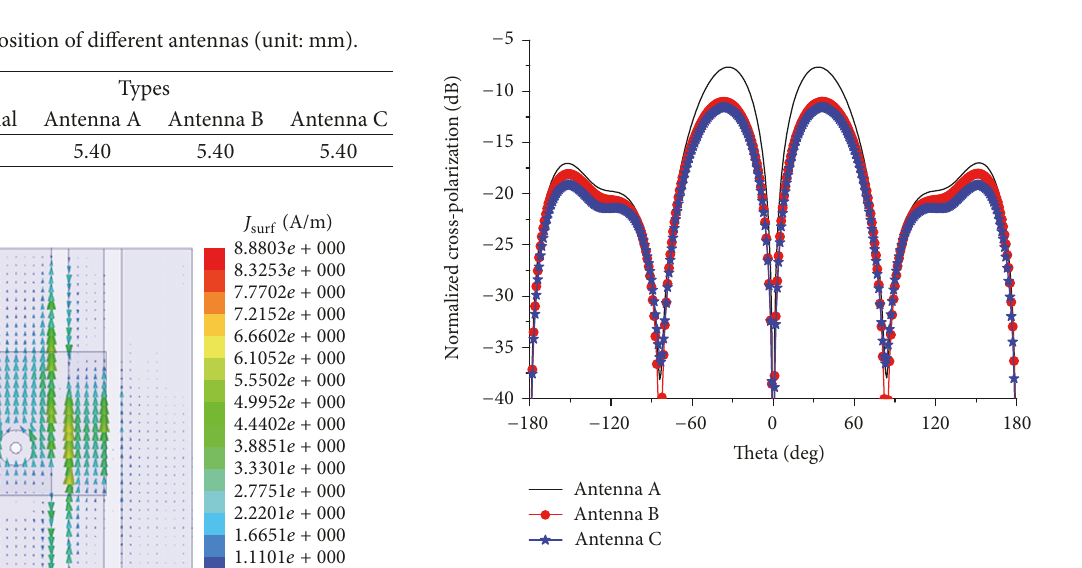
Figure 8: Comparisons of normalized cross-polarization at higher